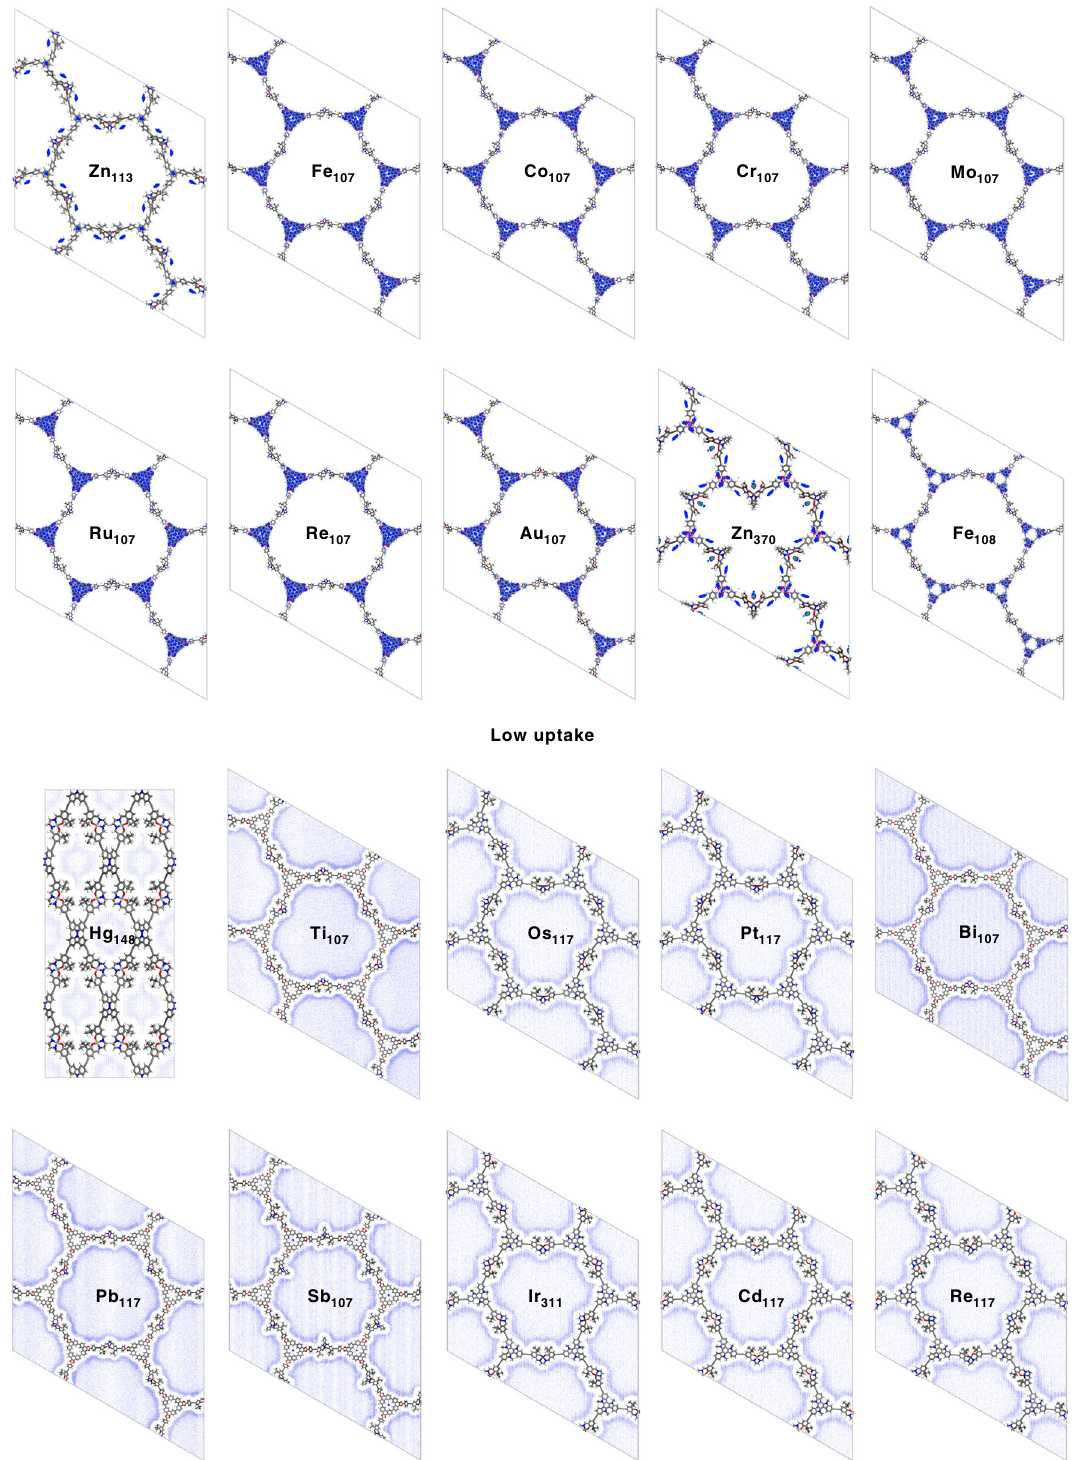
Fig. 2 CO 2 average densities. Ten Metal/Salen-COFs with the highest excess CO 2 adsorption amount (upper) and ten Metal/Salen-COFs with the lowest excess CO 2 adsorption amount (lower). The different shades of colour distinguish the degree of CO 2 uptake. Dark blue represents a large average It is worth noting that the transmission electron microscopy more details, see Supplementary Table 2). As shown in Sup- (TEM) images exhibit a regular channel structure (Fig. 4c); those plementary Fig. 5, scanning electron microscopy (SEM) images images exhibit a uniform honeycomb structure, which is in good revealed that all Zn-Salen-COF-SDU113 powders retained a agreement with the predicted structure. The measured average spherical morphology with an average particle size of 0.5 – 2 μ m.